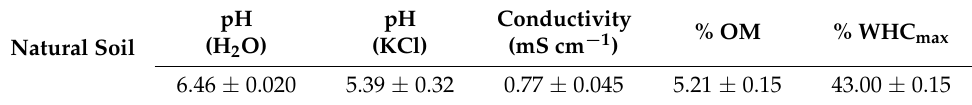
Table 1. Physicochemical characterization (mean values ± standard deviation (SD)) of the natural soil.